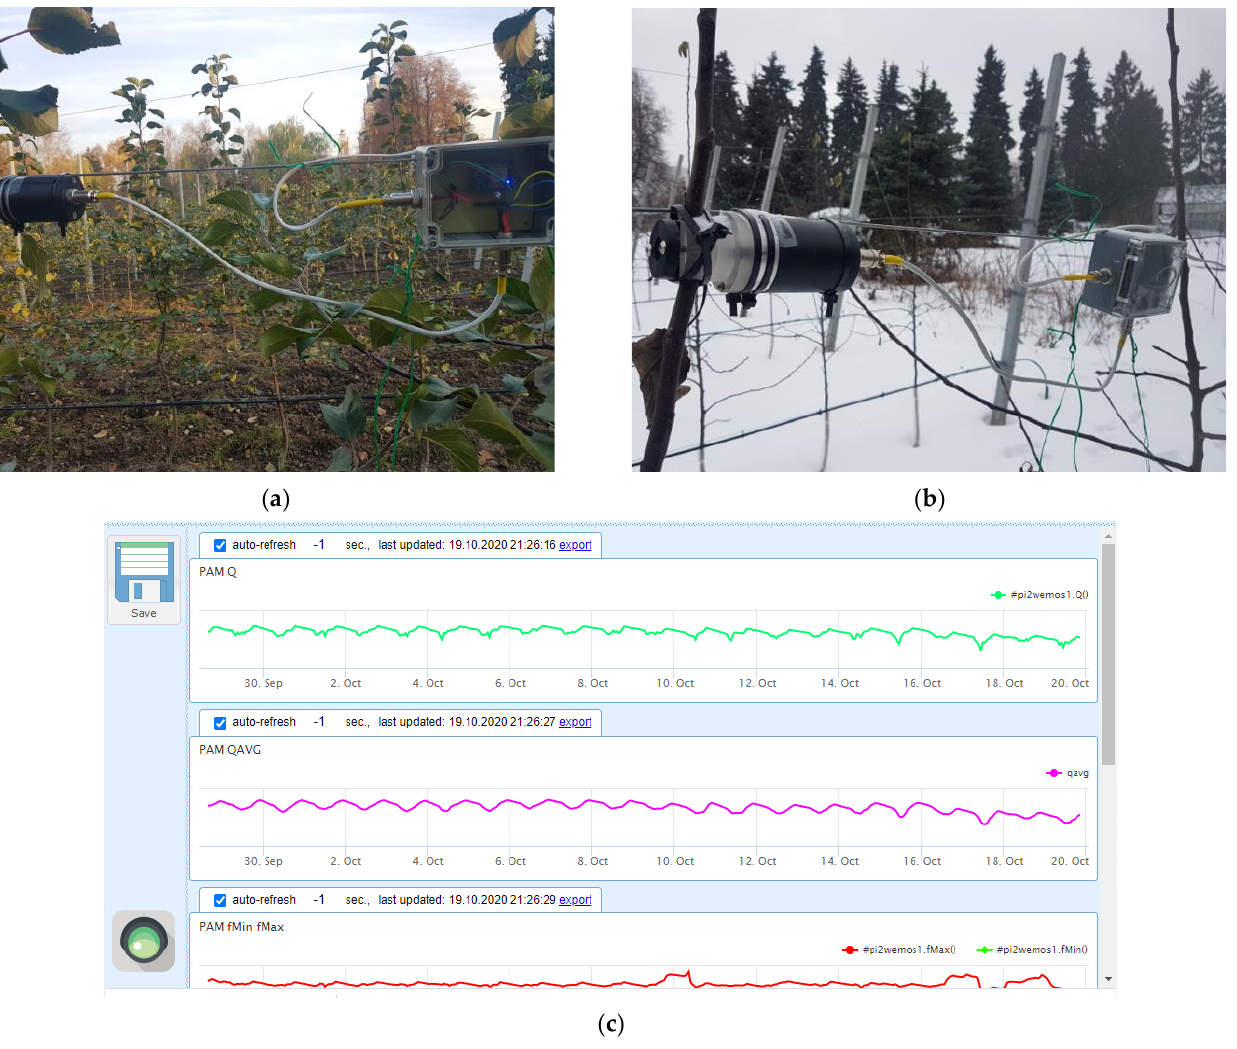
Figure 9. Sensors of variable chlorophyll fluorescence mounted on the monitored trees in the experimental orchard of Lomonosov Moscow State University in ( a ) fall and ( b ) winter seasons along with ( c ) a representative screenshot with hourly logged values of the OJIP parameters.